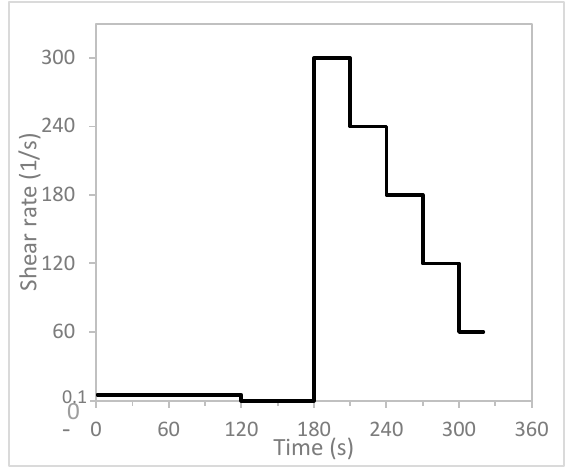
Figure 3. Rheological protocol.